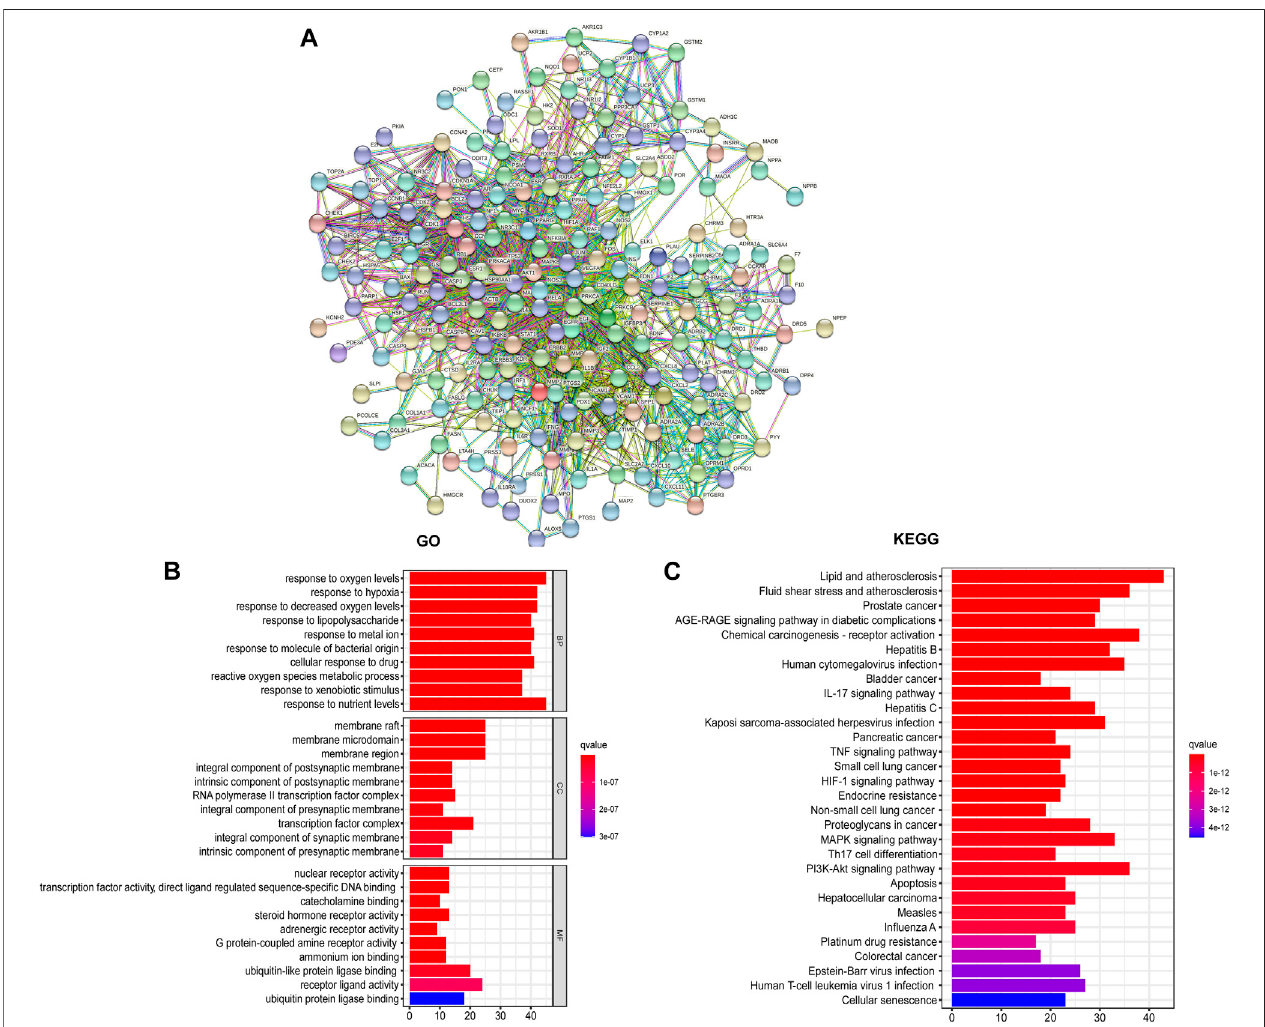
FIGURE 4 | PPI network of GCZX targets. PPI interaction network established by the target genes of GCZX in UC (A); GO and KEGG analysis of GCZX targeted genes (B).